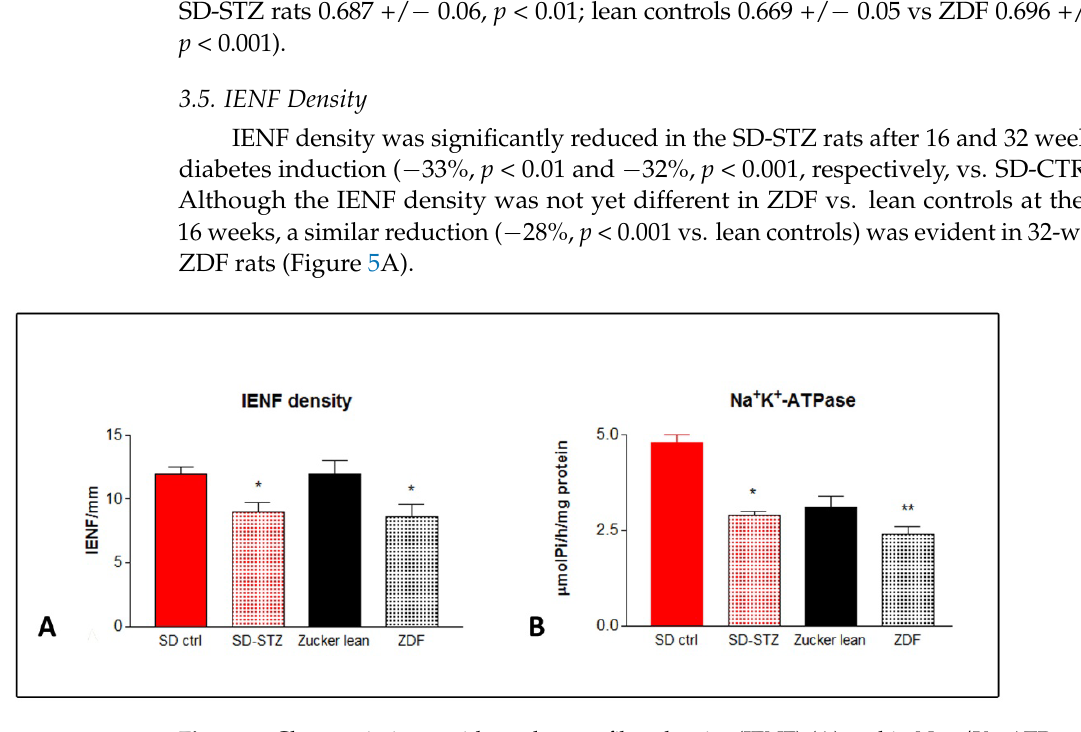
Figure 4. Representative light micrographs obtained from SD ( A , B ) and ZDF ( D , E ) rats with histo- grams of the distribution of myelinated fibres obtained in randomly selected sections ( C , F ). Mor- phometric analysis shows that diabetic rats (black bars) have an increased incidence of fibres of smaller diameter in comparison with the corresponding non-diabetic controls (white bars).